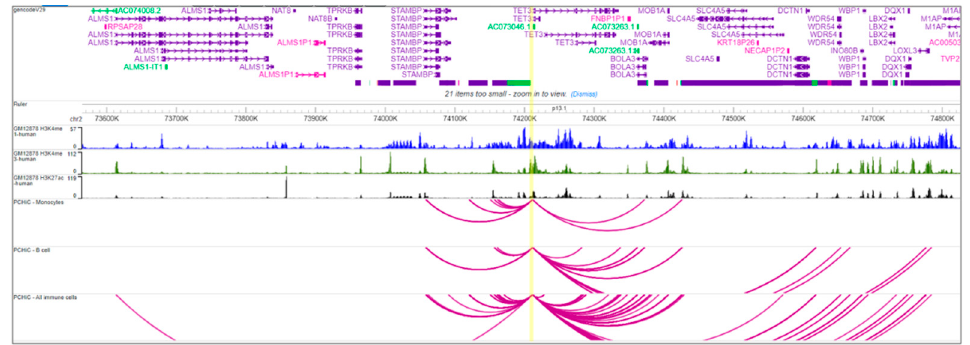
Figure 1. Chromatin interaction analysis using PCHiC showing the interacting region containing rs2272165 and promoters of neighboring target genes including DGOUK in GM12878 (B-lymphocytes) and monocytes. Chromatin interactions between the SNP (yellow vertical line) and target gene promoters are shown by magenta arcs.